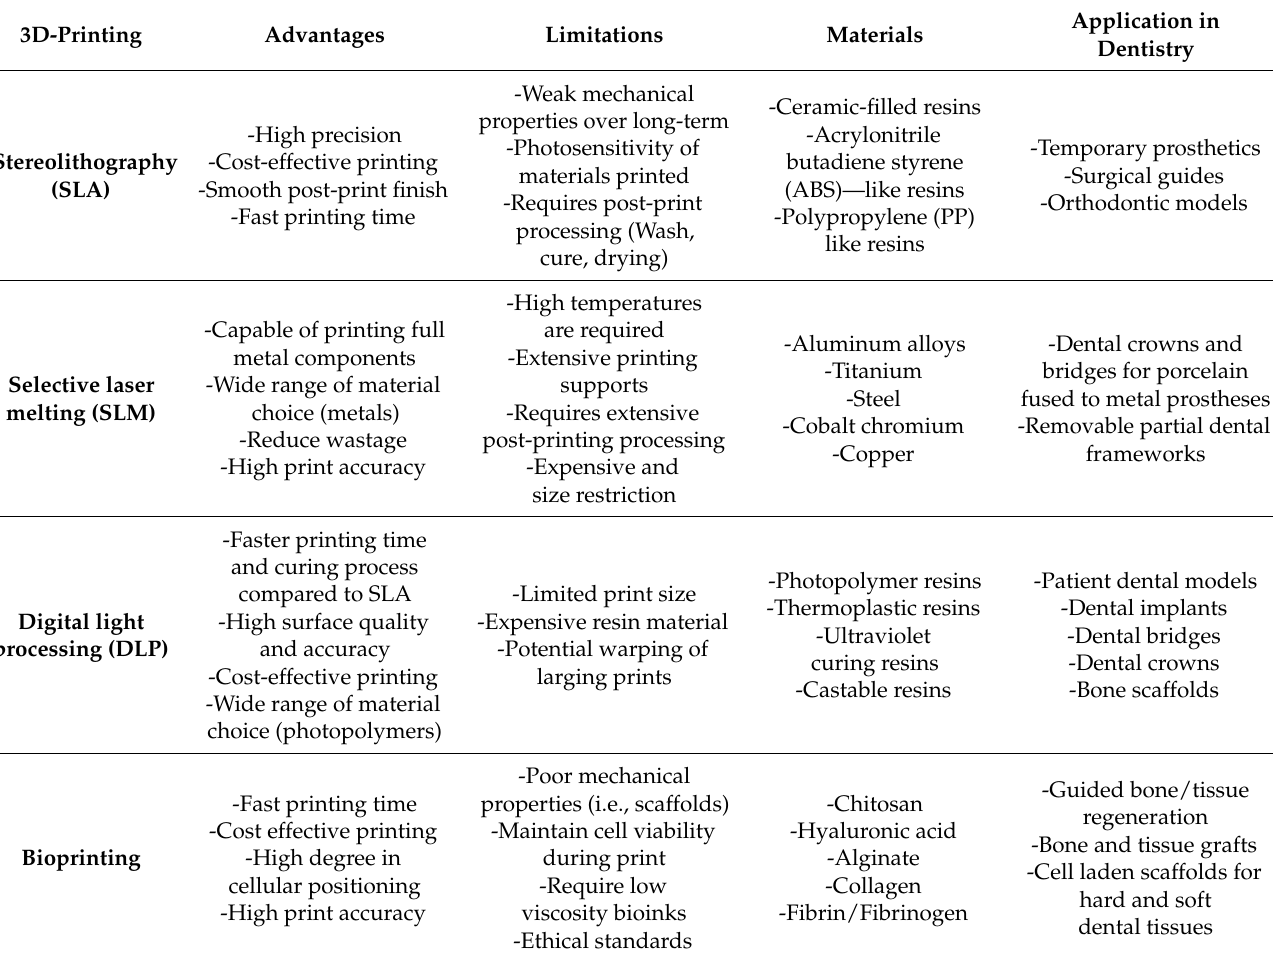
Table 2. Summary of the advantages and limitations of different 3D printing/additive manufacturing methods and their respective materials that are commonly used in the field of